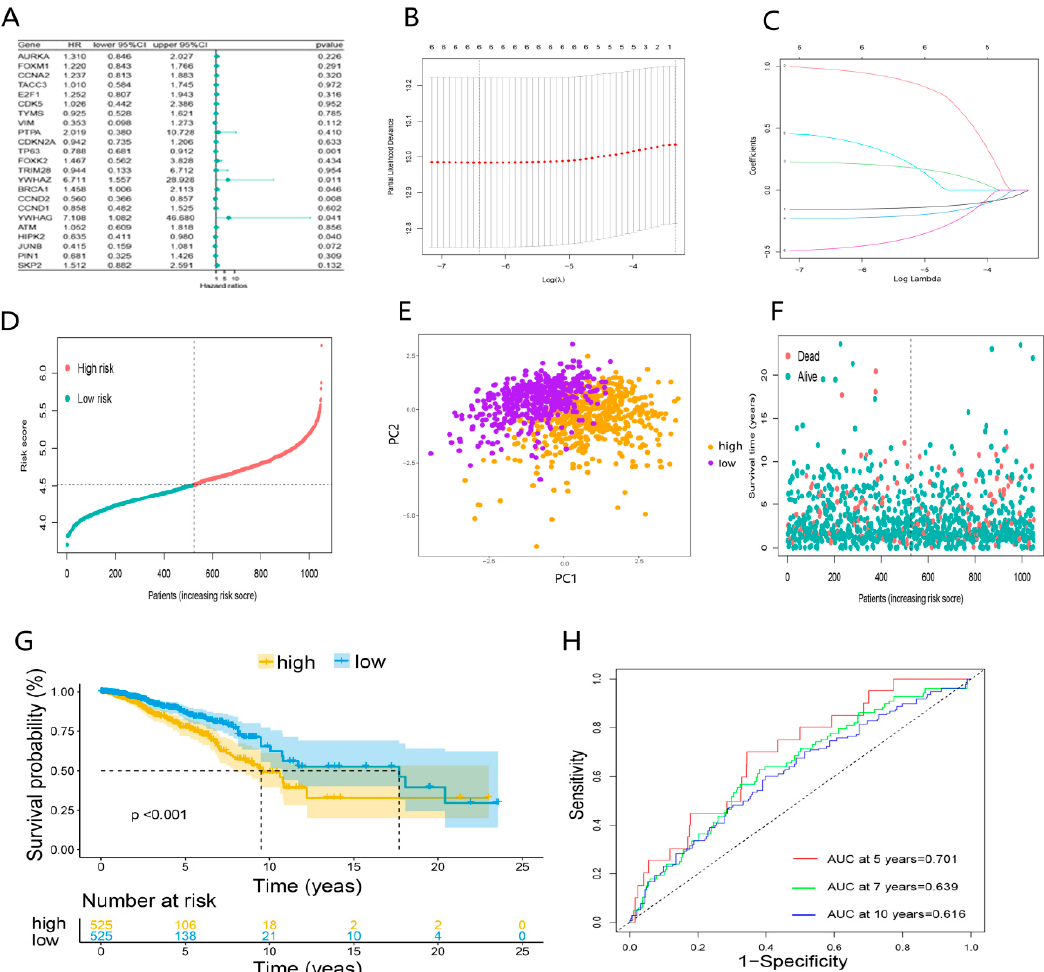
Figure 4. Establishment of DEDGs prognostic model based on the TCGA cohort: ( A ) forest plot of the univariate Cox regression for 23 DEDGs; ( B ) cross-validation for optimal parameter selection in the LASSO regression; ( C ) LASSO regression for 6 OS-related DEDGs; ( D ) distribution of patients based on the risk score; ( E ) principal component analysis (PCA) of 6 DEDGs; ( F , G ) the survival status and overall survival analysis of the two risk groups; ( H ) the time-dependent receiver operating characteristic (ROC) curve of 6 DEDGs.